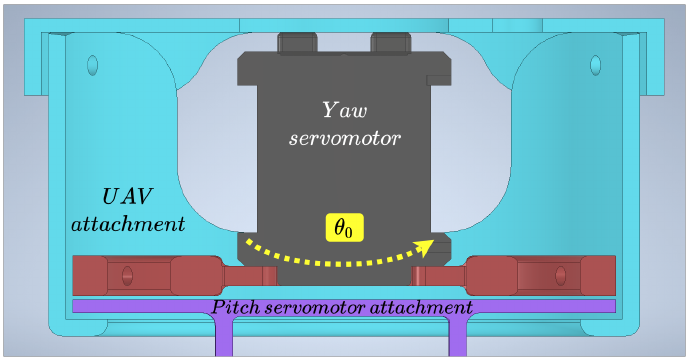
Figure 4. Design of the two-DOF cleaning